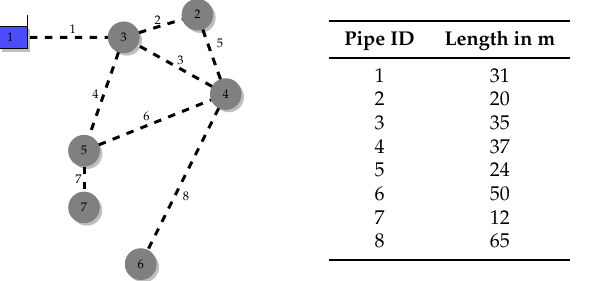
Figure 4. Problem instance: unoptimized network topology ( left ); pipe lengths ( center ); and available pipe types with their corresponding costs ( right